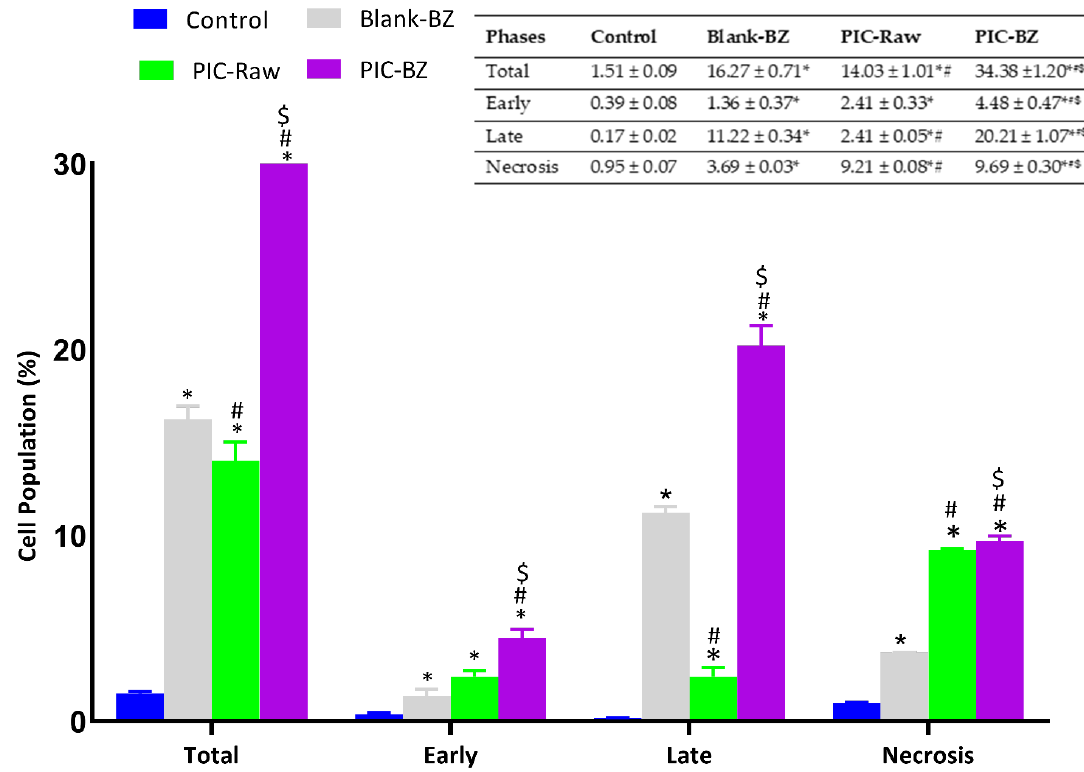
Figure 8. Impact of Blank-BZ, PIC-raw, or PIC-BZ treatments on the percentage of apoptotic or necrotic A549 cells with data table (inset). Total = apoptosis + necrosis; early = early apoptotic phase; late = late apoptotic phase. Data are the mean of 4 independent experiments ± SD. * Significantly different from control, p < 0.05; # significantly different from Blank-BZ, p < 0.05; $ significantly different from PIC-raw, p < 0.05.